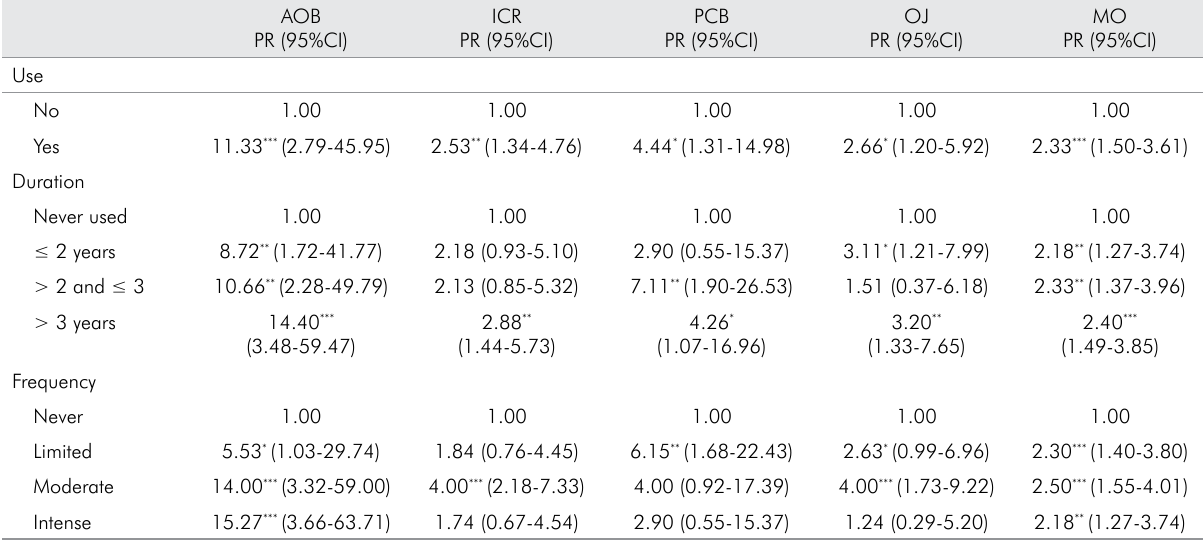
Table 3. Results of Poisson regression analysis of the association between pacifier use and the presence of dental occlusion alte- rations in preschool